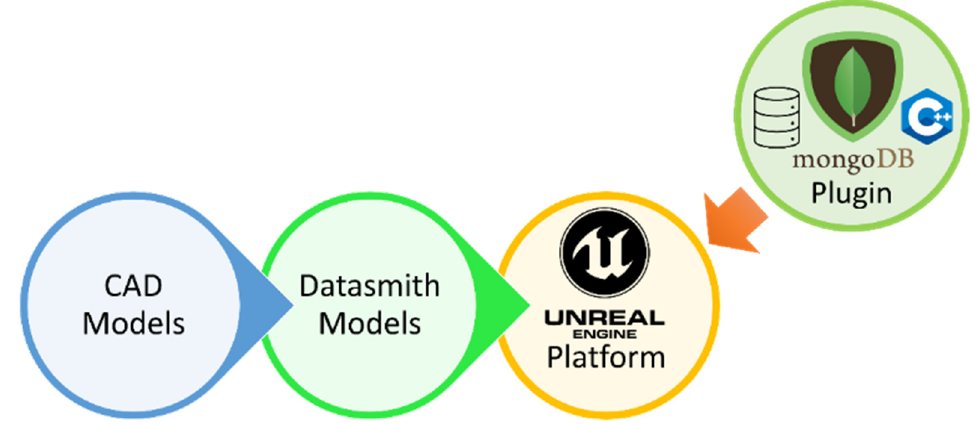
Figure 2. Platform architecture.